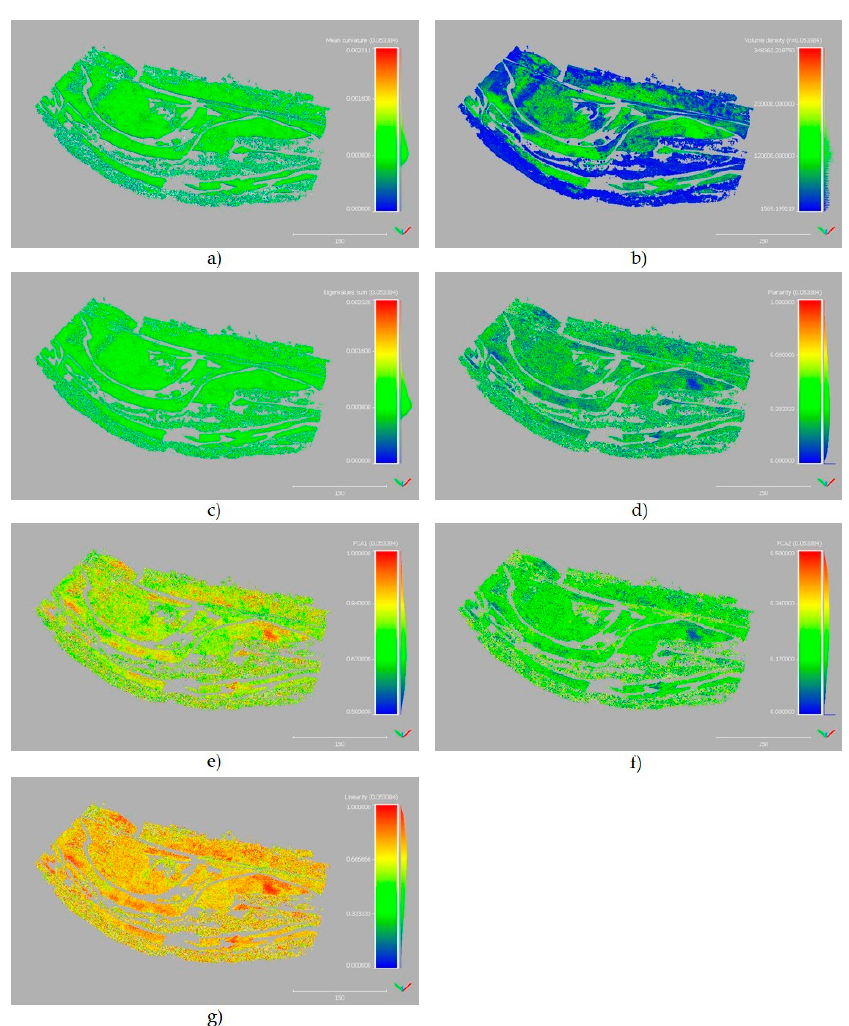
Figure 10. Geometric and shape-related features used in training phase; ( a ) Mean Curvature, ( b ) Volume Density, ( c ) Eigenvalues Sum, ( d ) Planarity, ( e ) PCA1, ( f ) PCA2, ( g ) Linearity, respectively.